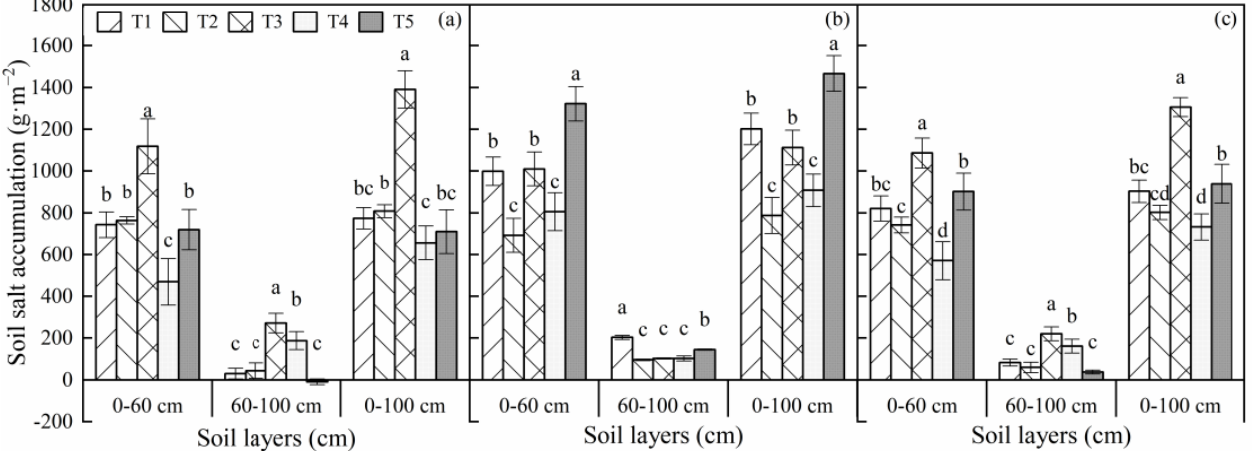
Figure 7. Soil salt accumulation for treatments in the boll opening stage of cotton. ( a ) Soil salt accumulation in the film; ( b ) Soil salt accumulation outside the film; ( c ) The total soil salt accumulation. Bars are the means + one standard error of the mean (n = 3). Different letters above the error bars indicate a significant difference at p < 0.05 according to the Duncan test.